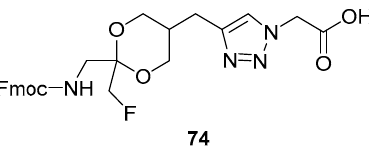
Figure 2. FMK moiety bound to linker for solid-phase peptide synthesis (SPPS) [31].